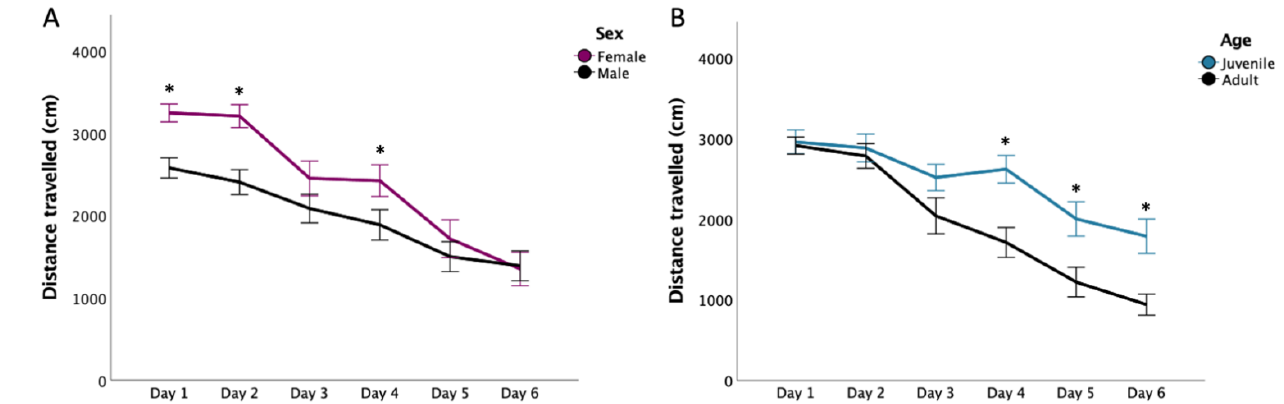
Figure 3. Distance Travelled to Reach the Escape Box in the Barnes Maze Test. Panel ( A ) shows the distance travelled (cm) by females and males, whereas panel ( B ) depicts the distance travelled by juveniles and adults. Data are presented as mean ± S.E.M. * Indicates statistically significant differ- ence between groups at p < 0.05. T1: Trial 1; T2: Trial 2. Pairwise comparisons for the Day*Sex interaction supported increased distance trav- elled by females compared to males on DAY1, 2 ( p < 0.0005 for each comparison), and 4 (marginal p = 0.05). However, both sexes showed reduced distance travelled as testing days progressed ( p < 0.05; see Figure 3A). The Day*Age interactions was attributable to longer distance travelled in juveniles compared to adults on DAY4 ( p < 0.0005), 5 ( p = 0.007), and 6 ( p = 0.001). Juvenile rats also travelled more on DAY1 ( p = 0.002), 2 ( p = 0.003), and 4 ( p < 0.0005) than on DAY5 and more on DAY1 through 4 than 6 (all p < 0.007). Adult rats similarly travelled more on DAY1 and 2 than on DAY3, 4, 5, and 6 (all p ≤ 0.001; see Figure 3B). Pairwise comparisons for the Trial*Supplementation interaction supported increased distance travelled in both FO and CSO rats in Trial 1 when compared to Trial 2 (both p < 0.0005). As for the Day*Trial interaction, post hoc comparisons supported rats to travel longer distances during the first compared to the second daily trials from DAY2 through DAY6 (all p < 0.002). Similarly, travelled distance for both Trials 1 and 2 gradually de- creased over testing days (all p < 0.035). Three-way interactions of Age, Sex and Supple- mentation during the first trial F (1,55) = 0.12, p = 0.728; or during the second trial F (1,55) = 1.30, p = 0.259 were not significant. 3.3. Acquisition Phase: Number of Working Memory Errors (WME) For the number of WMEs, five-way mixed ANOVA revealed main effects of Day and Trial, and significant interactions for Day*Age, Day*Supplementation*Sex, Day*Sex*Age, Trial*Age, Day*Trial, Day*Trial*Age, and Day*Trial*Supplementation*Sex (See Table 1). Pairwise comparisons for Day*Age showed that adults made more WME than juveniles on DAY1 ( p = 0.003), while thereafter juveniles made more WME compared to adults [DAY3,4, 5 and 6 — all p < 0.0005]. The juvenile rats made fewer WME on DAY1 compared to DAY2 ( p = 0.006), 3, 4, 5, and 6 (all p < 0.0005). As Figure 2B illustrates, post hoc analyses related to the Day*Supplementation*Sex interaction showed reduced WME in CSO- com- pared to FO-fed males ( p = 0.017) and reduced WME in CSO males compared to female counterparts ( p = 0.05). On DAY4, CSO males made less WME than FO males ( p = 0.05) while FO- females made less WME than FO-fed males ( p = 0.034). An effect of age emerged from post hoc comparisons assessing the Trial*Age interac- tion, which supported reduced WME in adult compared to juvenile rats during Trial 1 and Trial 2 (both p < 0.005). The juvenile and adult cohorts made more WME during Trial